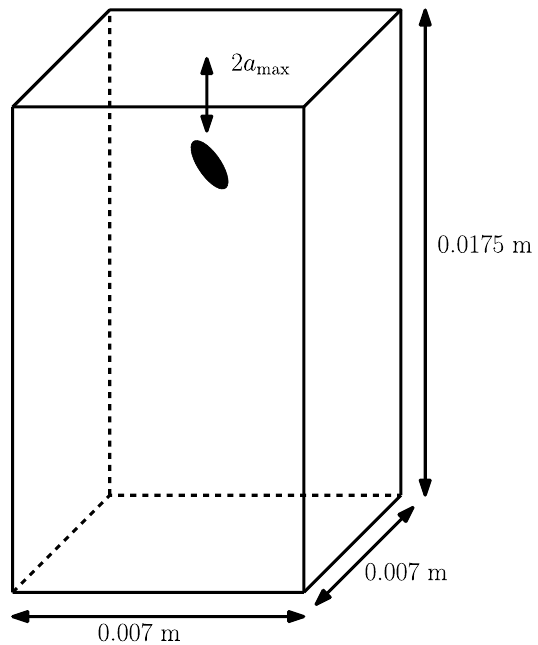
Figure 2. Initial configuration of the